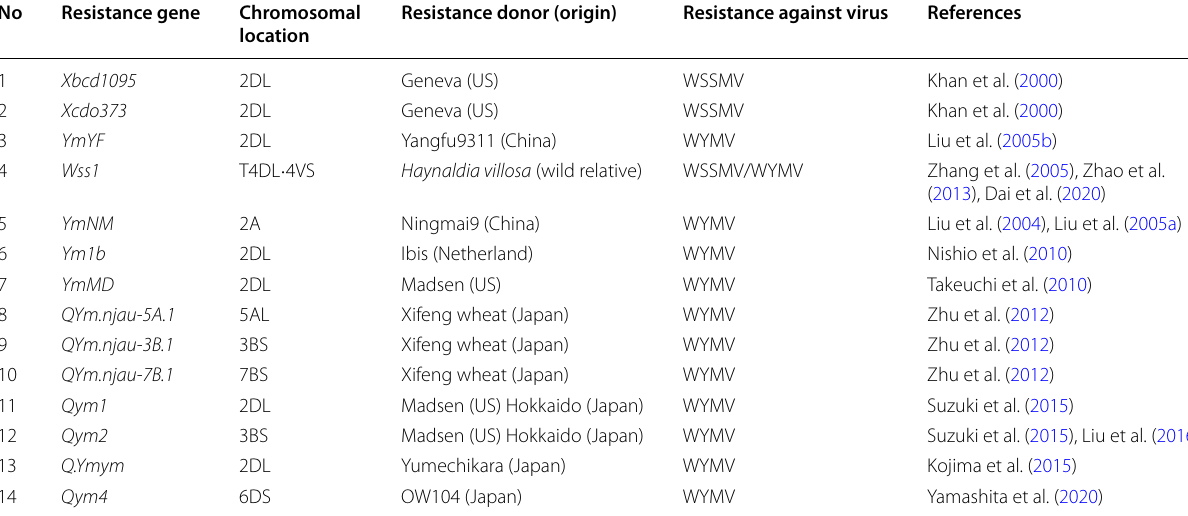
Table 1 Summary of bymovirus resistance genes and QTLs in wheat No Resistance gene